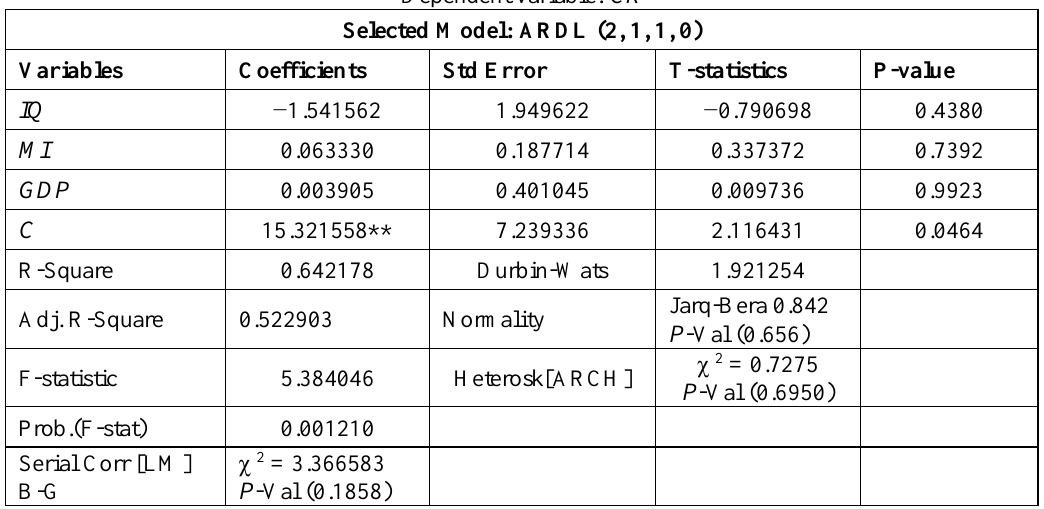
Table 4. Estimated Method: Long-Run Coefficients of